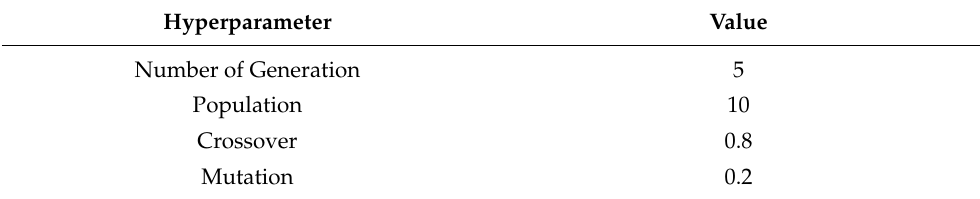
Table 1. Control parameters of GA.